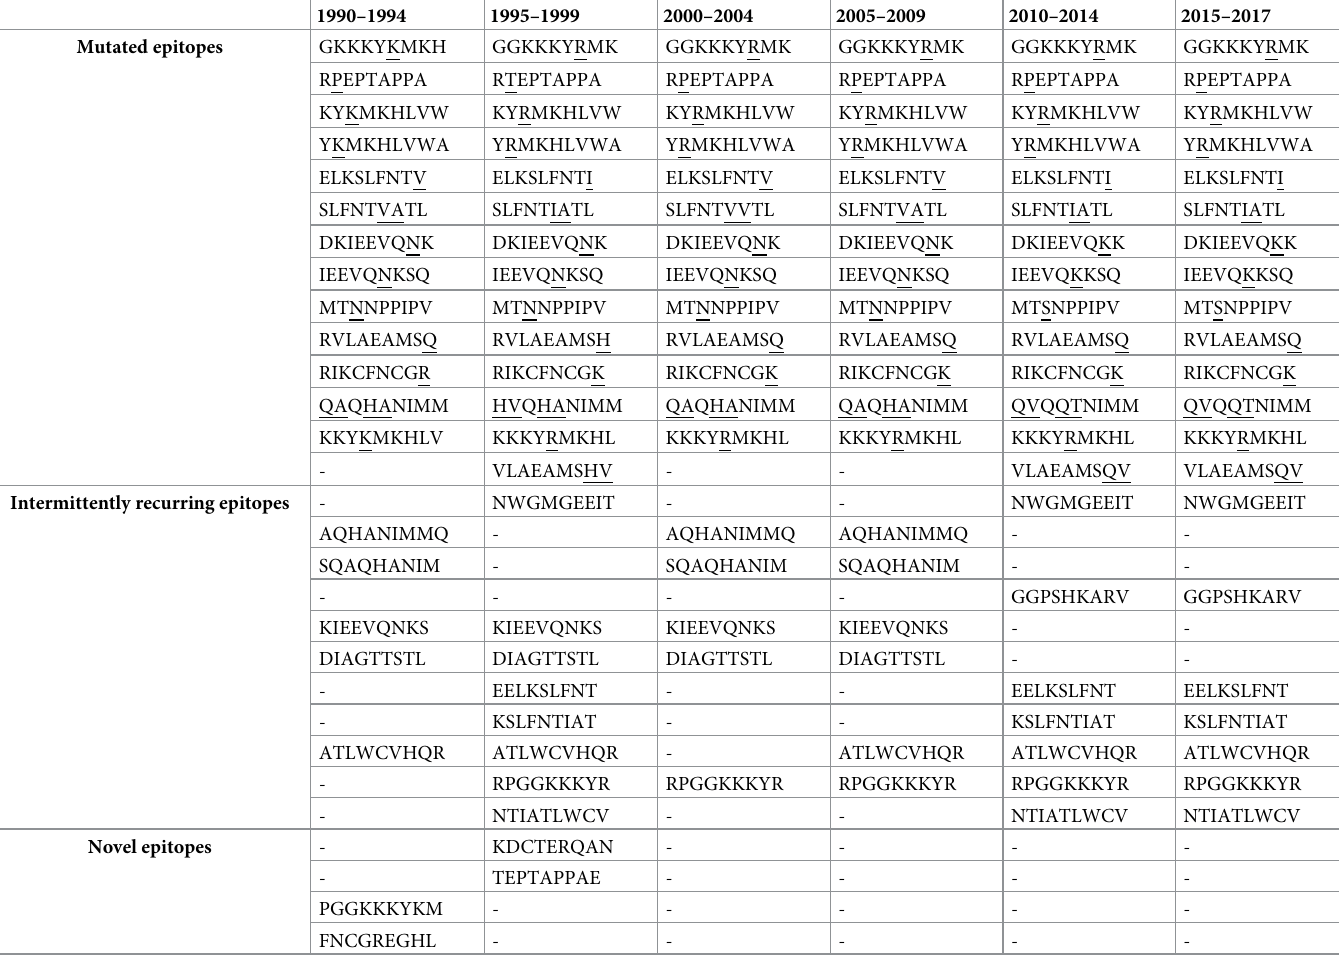
Table 1. HIV-1 CRF01_AE gag CTL mutated and novel epitopes. The epitopes are divided into three categories: Novel epitopes (epitopes unique to one year group), intermittently recurring epitopes and mutated epitopes. Mutation(s) in epitope are underlined, while ‘-‘ in the table represents the absence of epitope in a particular year